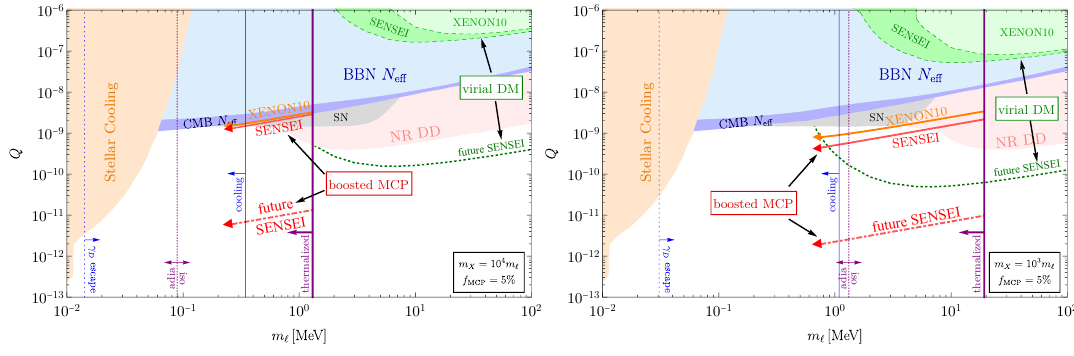
Figure 6 . The parameter space of our model in the m ‘ − Q plane. The potential detector reach of XENON10 in orange and of SENSEI in red (dash-dotted is a future prediction) are for the boosted MCP. The purple and blue vertical lines show the crossover parameter regions for the halo behavior derived in section 4. Additional constraints are from stellar cooling (light orange) and BBN/CMB N eff (light blue and blue) [79], SN1987A (gray) [80], XENON10 and SENSEI constraints on virial milli-charged DM, assuming the same n ‘ as in the boosted MCP (light green and green) [25, 26], the future projection of SENSEI in the virial case (dotted green) [78] and nuclear-recoil direct-detection constraints on the X partner (pink) [81, 82]. See the text for more